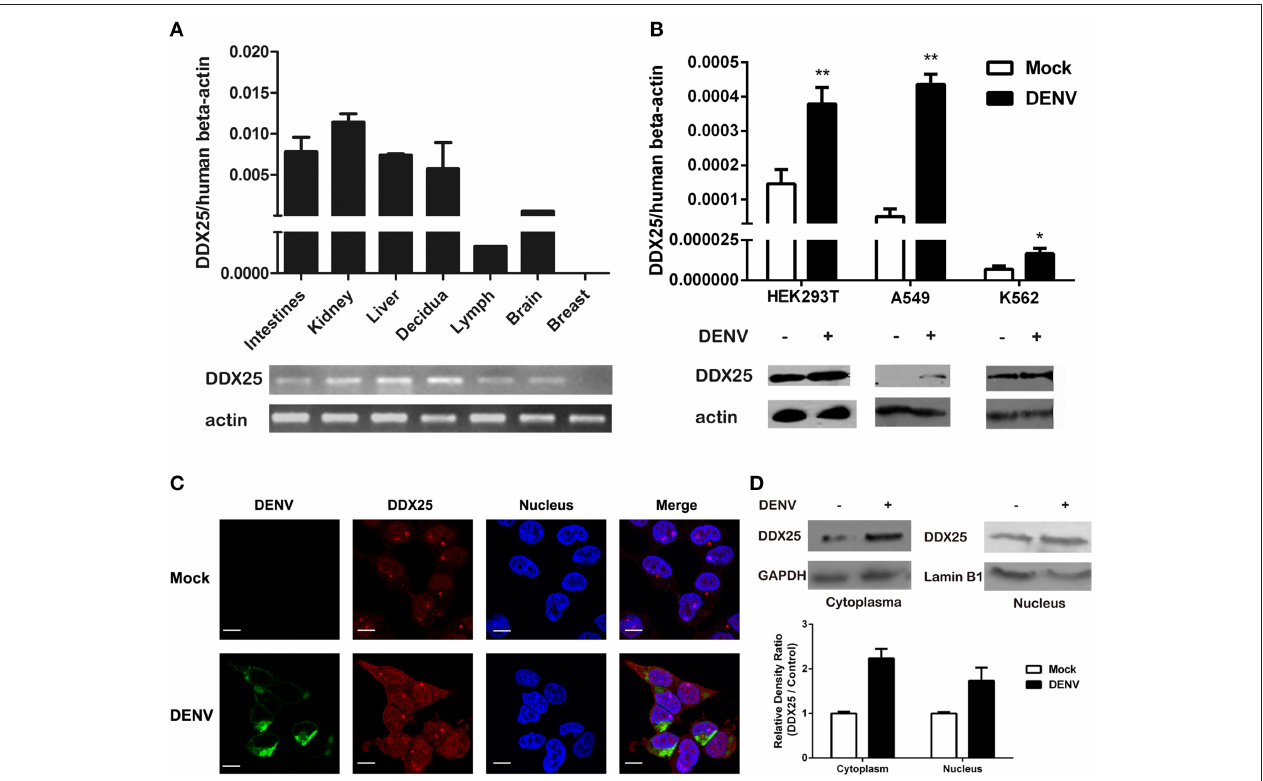
FIGURE 1 | Human DDX25 is ubiquitously expressed and upregulated after DENV infection. (A) qRT-PCR and electrophoresis analysis of DDX25 expression in various human tissues. Human β -actin was used as an internal control. (B) The qRT-PCR and immunoblots analysis of DDX25 expression in HEK293T, A549, and K562 cells before and after DENV infection. (C) Microscopic images of immunofluorescence staining for expression and subcellular distribution of DDX25 in HEK293T with or without DENV infection. (MOI of 1 for 24 h). Scale bars, 10 µ m. (D) Immunoblots analysis of DDX25 expression in the cytoplasm and nucleus before and after DENV infection. The relative gray density of immunoblots bands (DDX25/ β -actin) was analyzed by ImageJ software. Results were expressed as the mean + the SEM. * p < 0.05 and ** p < 0.01 ( t -test). Representative results from at least three independent